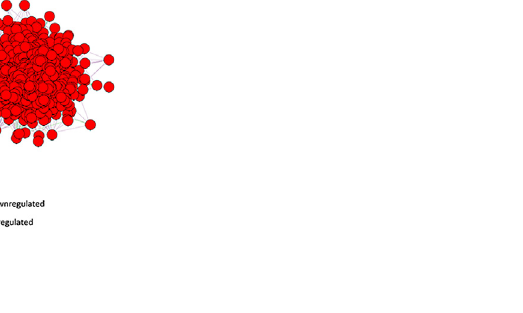
Table 1. Parameters of inferred networks of up- and down-regulated genes. Number of Inference Parameters